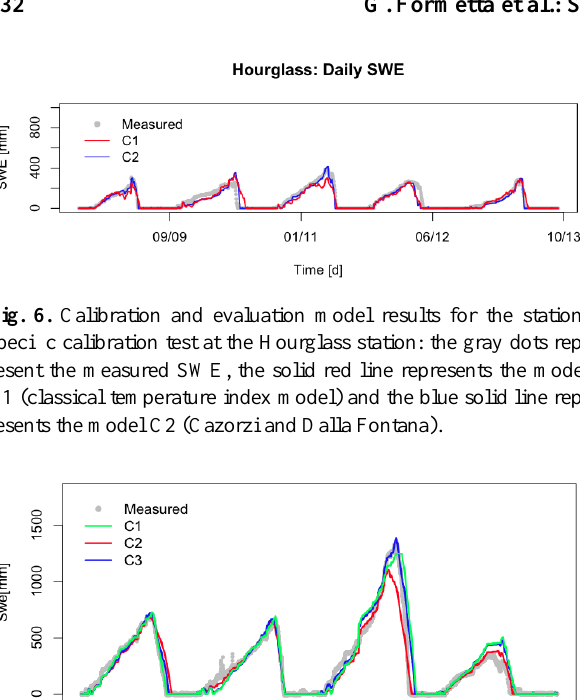
specific calibration test in Joe Wright: the gray dots represent the measured SWE, the solid red line represents the model C1 (classi- cal temperature-index model) and the blue solid line represents the modelC2(CazorziandDallaFontana).